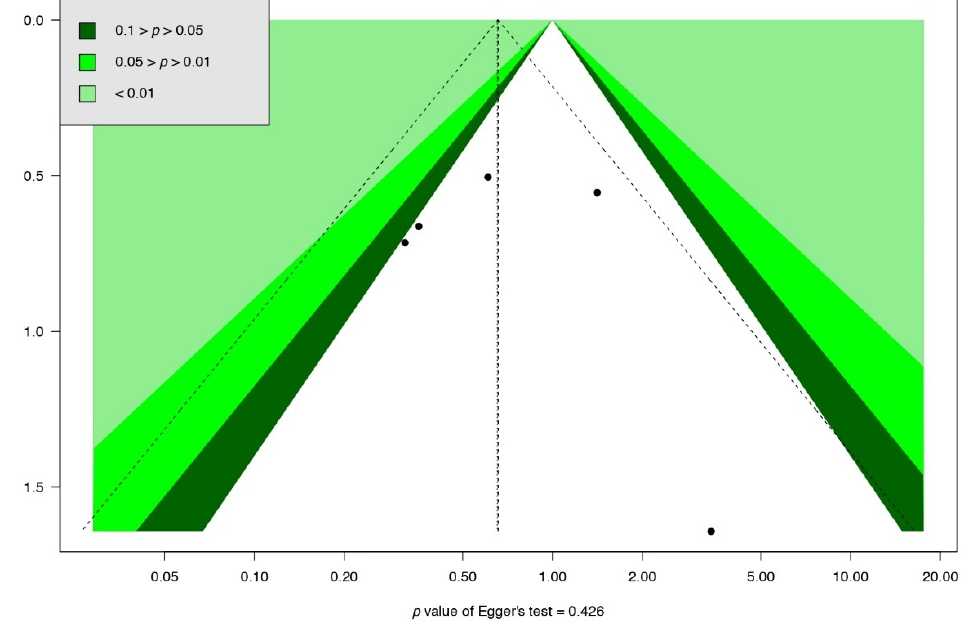
Figure A41. Comparison-adjusted funnel plot in outcome for post-operative fever.